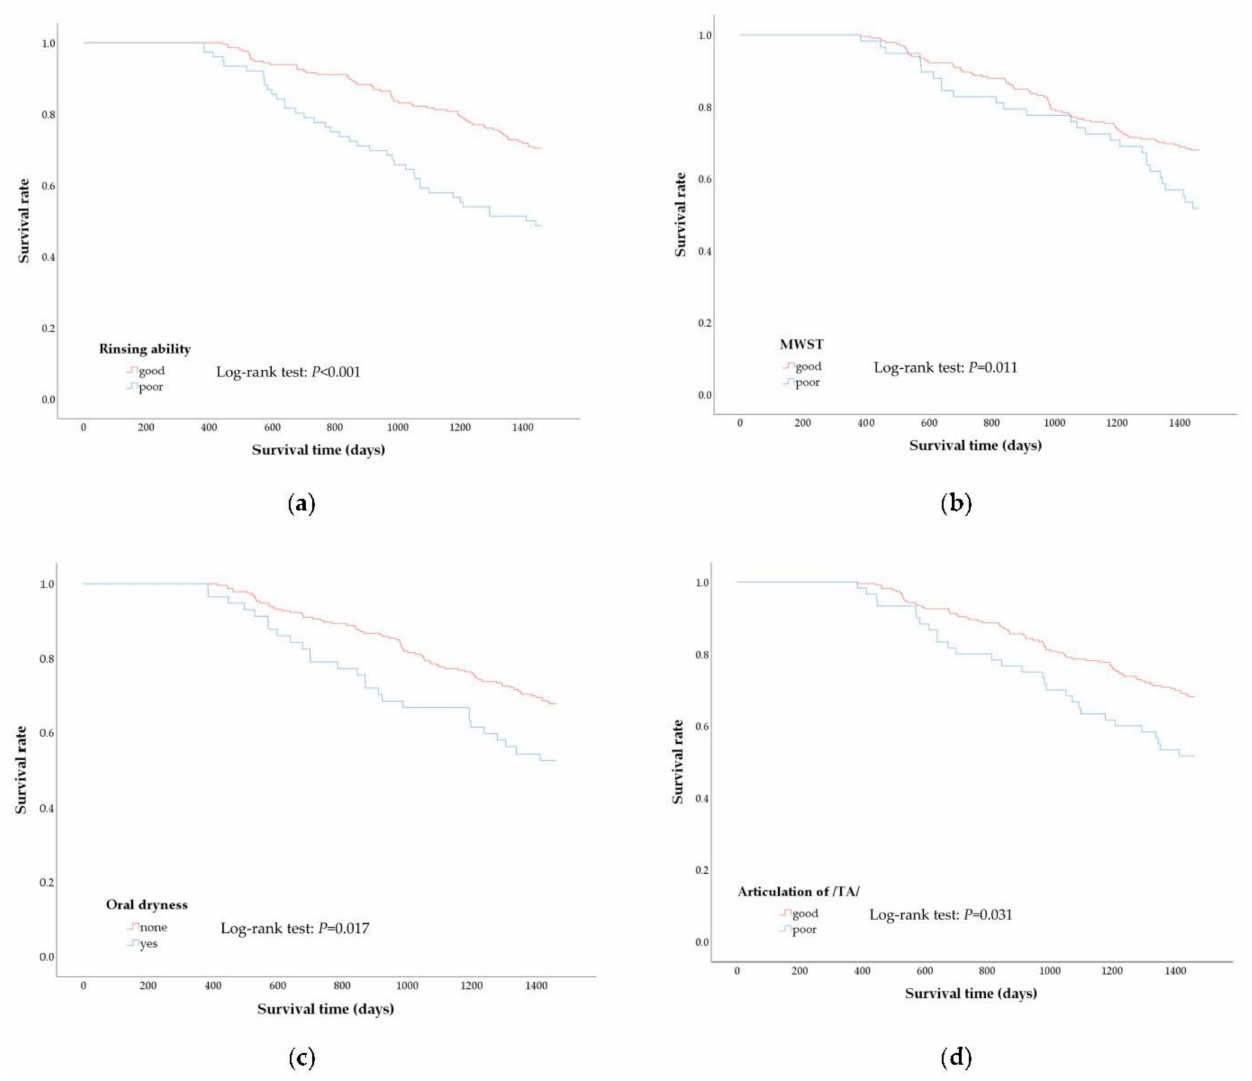
Figure 2. Kaplan–Meier curves and results of Log-rank test between poor and good oral function group. Kaplan-Meier curves represent the difference in survival rate according to oral function as assessed by rinsing ability ( a ), modified water swallowing test ( b ), oral dryness ( c ), and articulation of /Ta/ ( d ) during the 4-year observational